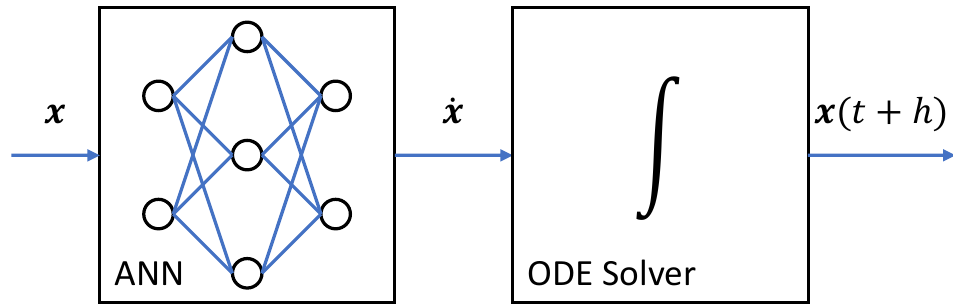
Figure 2. Topology of a NeuralODE consisting of a feed-forward ANN and a numerical ODE solver. The current system state x is passed to the ANN based on the following: the state derivative ˙ x is calculated and integrated into the next system state x ( t + h ) by the ODE solver with the time step size h .